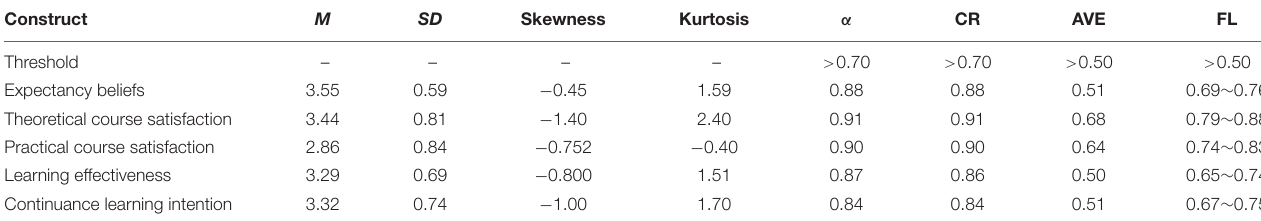
TABLE 3 | Reliability and validity analysis.